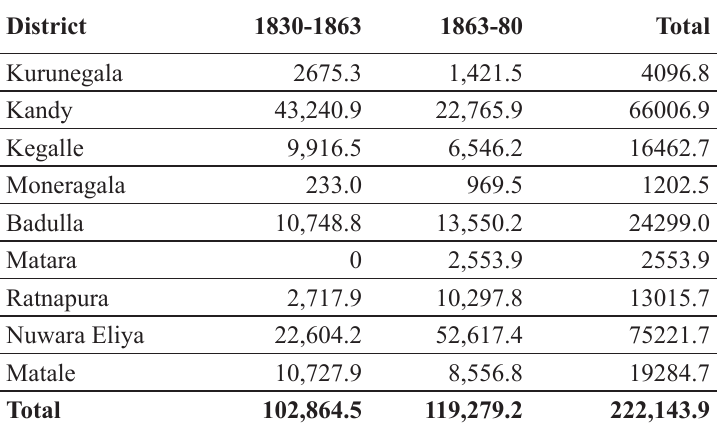
Table 2: District-wise distribution of coffee plantations (ha).